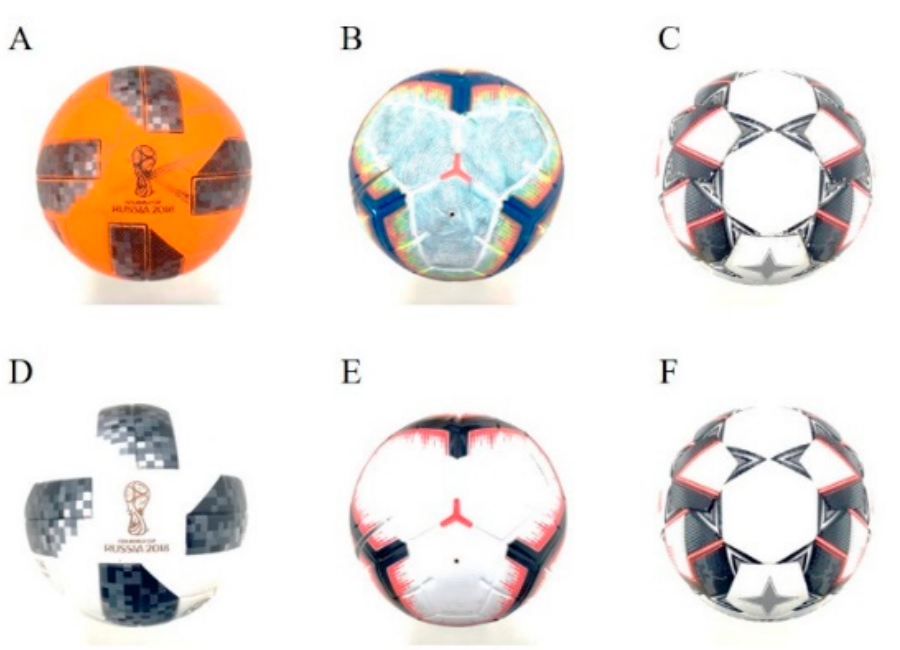
Figure 2. Soccer balls used in the tests. ( A – C ) are the Telstar 18, Merlin, and Derbystar used balls, respectively. ( D – F ) are the Telstar 18, Merlin, and Derbystar new balls, respectively.